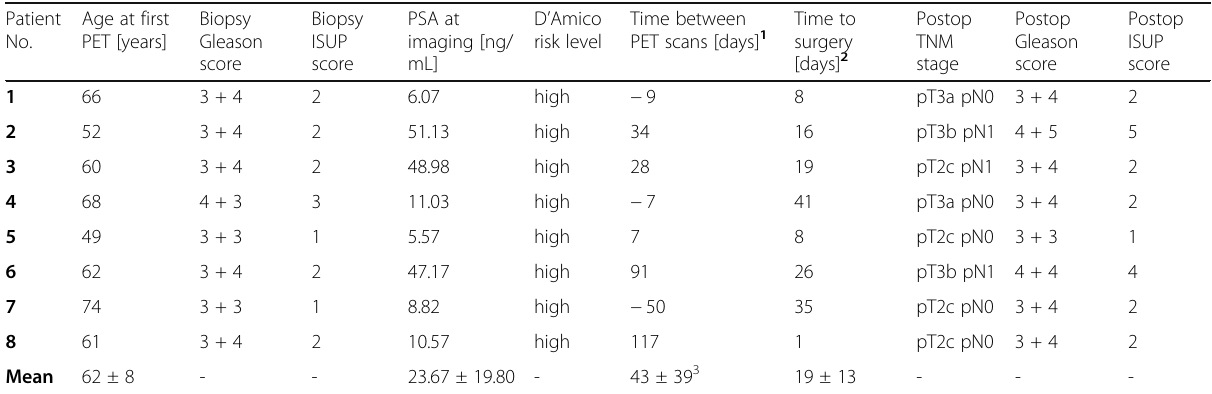
Table 1 Patients ’ characteristics Patient